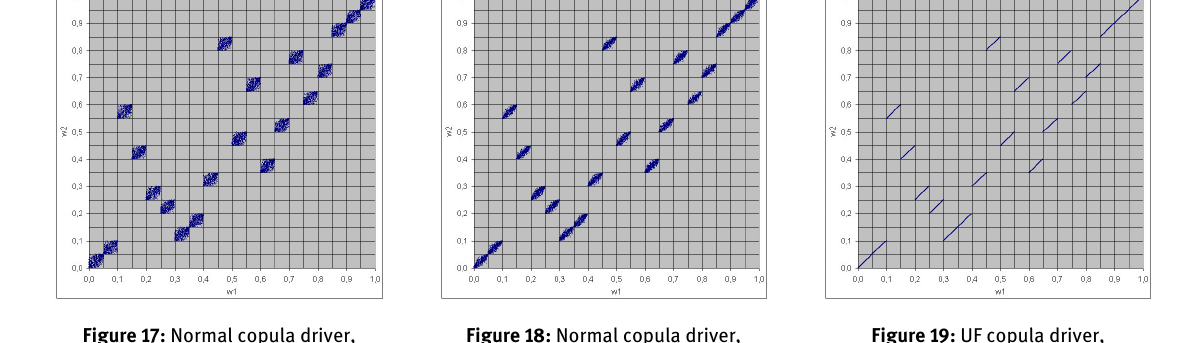
Figure 18: Normal copula driver, ρ = 0.9